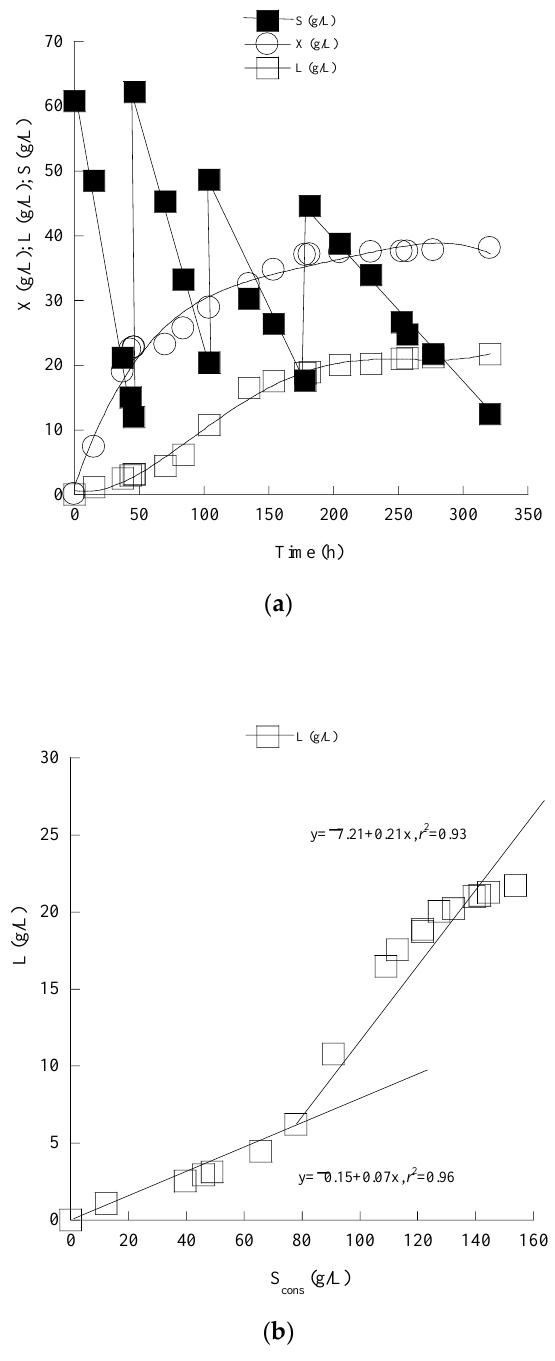
Figure 3. ( a ) Kinetics of C. curvatus ATCC 20509 fed-batch cultivation in the complex substrate, centrifugated, and filtrated second cheese whey, with initial lactose concentration S 0 ≈ 60 g/L, presenting the pulsed feeding, dry biomass, and lipid production. ( b ) Fed-batch trial divided into two well-separated phases; the phase in which lactose is mainly consumed in order to produce lipid-free biomass (in this phase the conversion yield of lipid produced per unit of lactose consumed was c. 0.07 g/g), and the main lipid-producing phase, in which lactose was mainly channeled towards the synthesis of SCO (in this phase, the conversion yield of lipid produced per unit of lactose consumed was c. 0.21